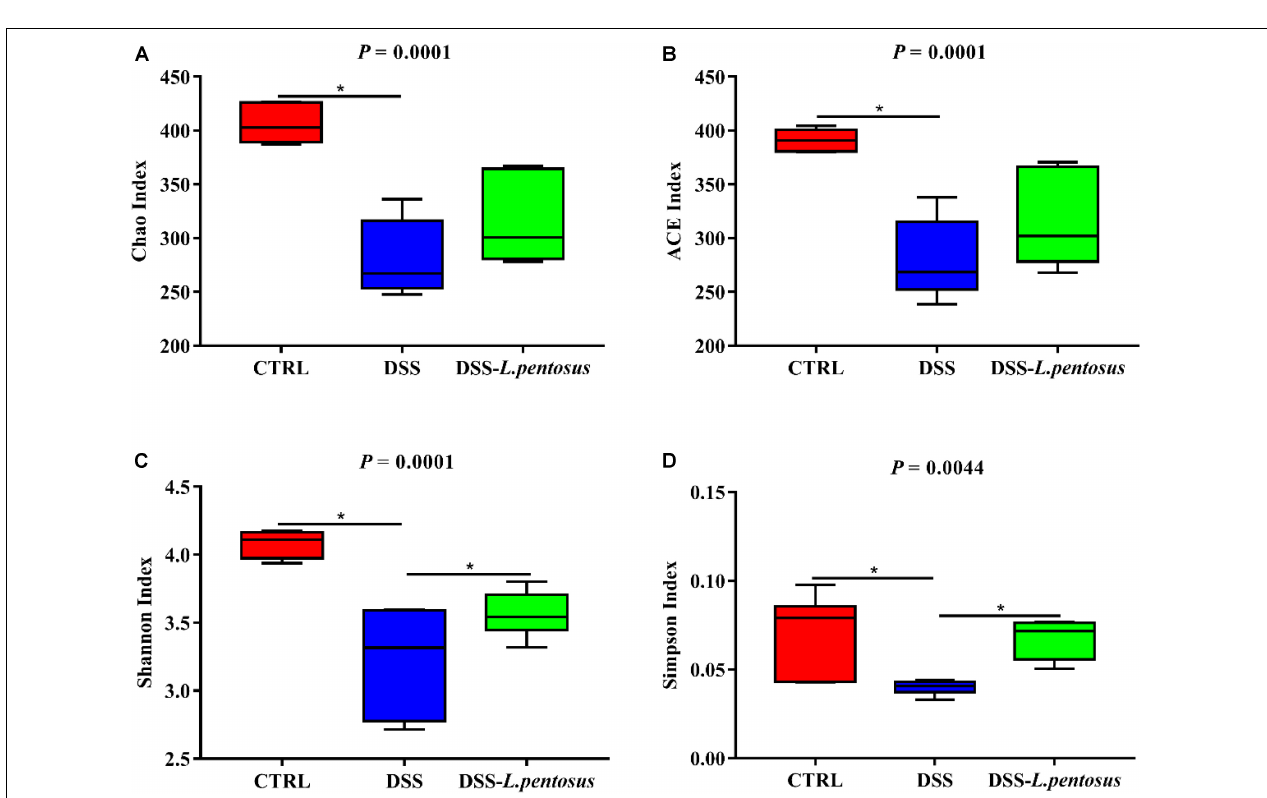
FIGURE 6 | Effects of different treatments on α -diversity of mouse intestinal microbiota. (A) Chao index; (B) ACE index; (C) Shannon index; (D) Simpson index. Data are mean ± SD ( n = 8) and analyzed by one-way ANOVA. * p < 0.05.